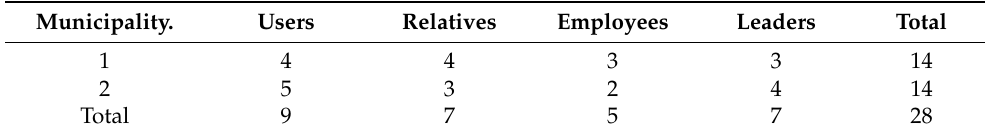
Table 1. Included respondents by type and municipality.